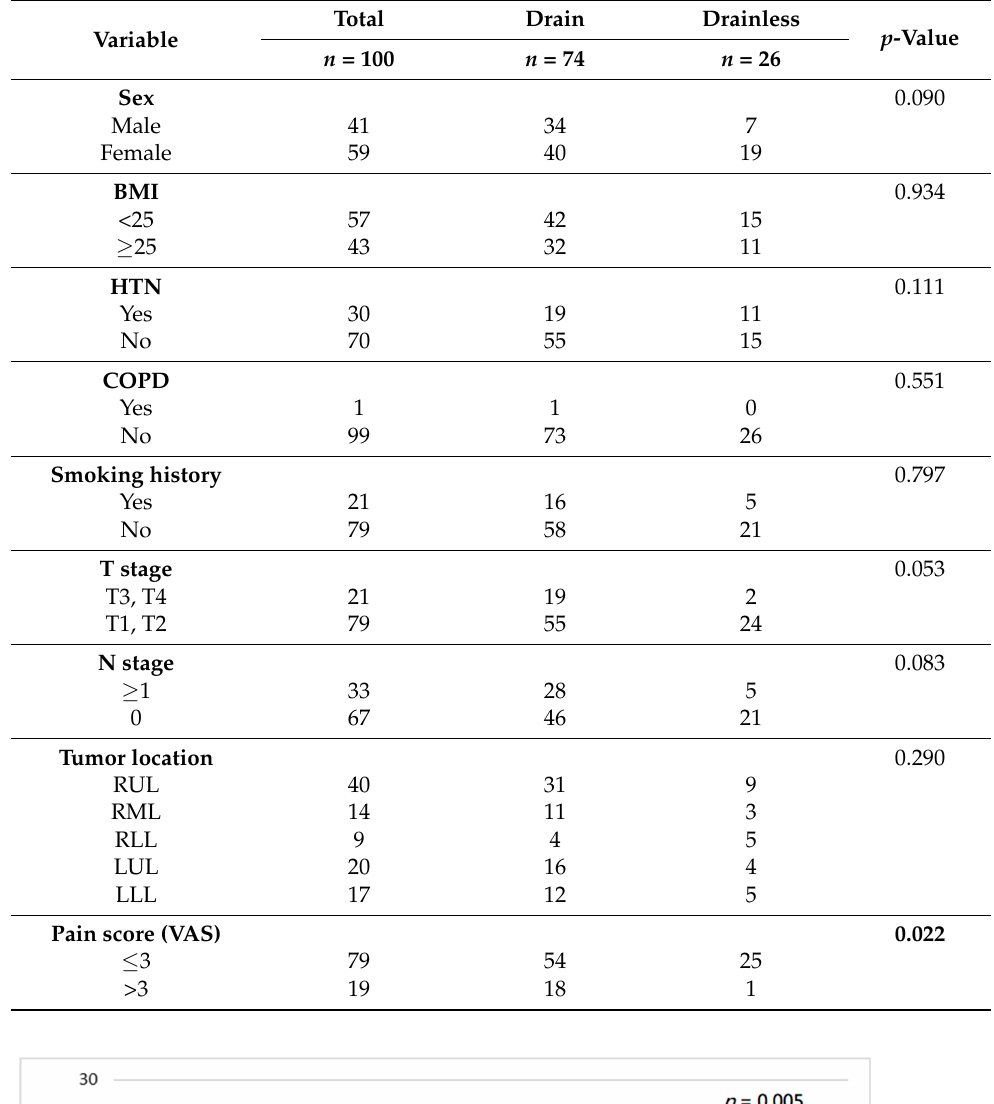
Table 1. Characteristics of patients in the drain and drainless groups before propensity score matching.